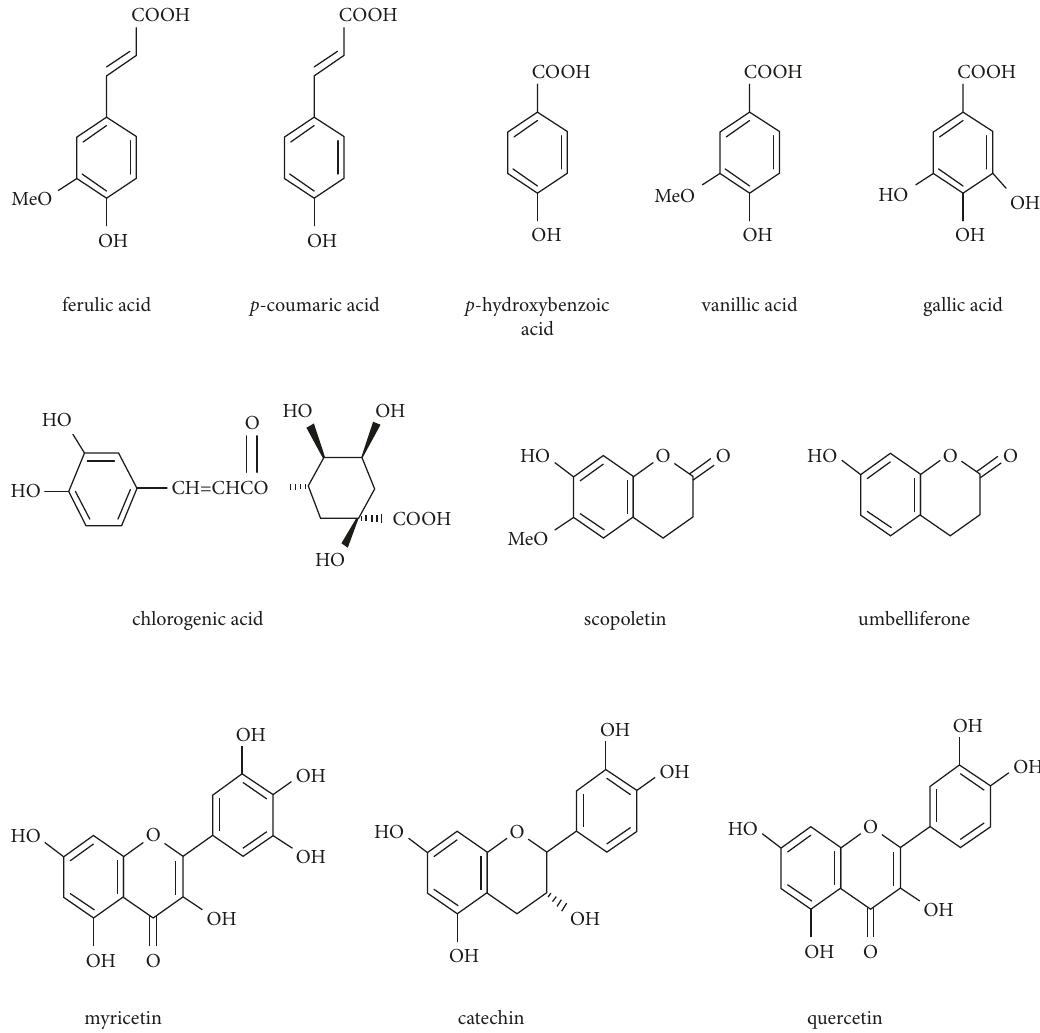
Figure 2: Chemical structures of some common compounds leading to allelopathic effects such as (a) ferulic acid; (b) (p)-coumaric acid; (c) (p)-hydroxybenzoic acid; (d) vanillic acid; (e) gallic acid; (f) chlorogenic acid; (g) scopoletin; (h) umbelliferone; (i) myricetin; (j) catechin; and (k)